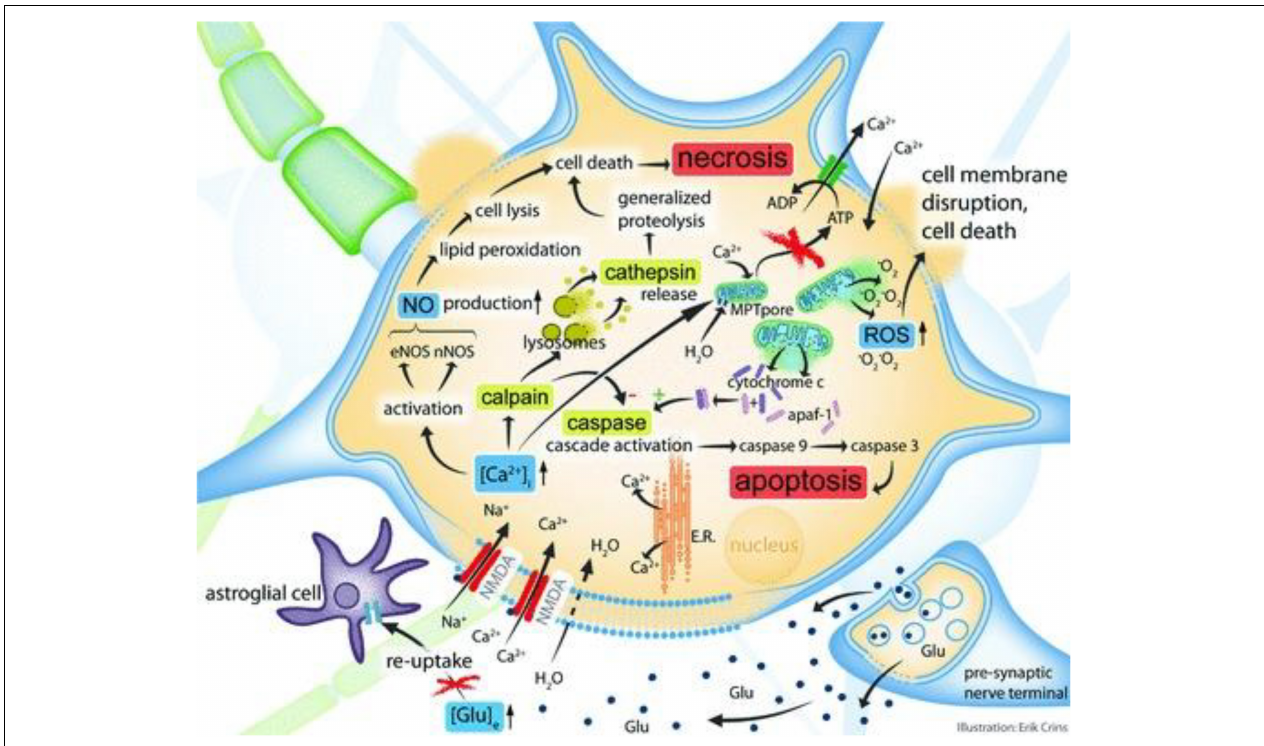
FIGURE 1 | Simplified cellular and molecular pathophysiological pathways after localized TBI. The figure is used to accompany the record provided in the actual section. In summary, elevations in extracellular glutamate cause a supraphysiological Ca2 + influx, which then activates some intracellular cascades acting in tandem (four are shown). Upregulation of the calcium-dependent enzymes eNOS and nNOS results in increased nitric oxide generation, which finally results in necrosis of cells and lipid peroxidation. The activity of calpain (a cystein protease) is also increased as a consequence of increased intracellular calcium, eventually culminating in cellular necrosis pathways. This process is facilitated by cathepsin release and lysosomal membrane disruption. Developments in intracellular calcium that cause mitochondrial calcium overload enhance the permeability of the mitochondrial membrane. As a consequence, reactive oxygen species (ROS) and the cytochrome-c protein are discharged into the cytoplasm. Cytochrome-c interacts with the apoptosis activating protein-1 (apaf-1), initiating the caspase pathway that induces apoptosis. Glu, glutamate; [Glu]e, extracellular glutamate concentration; NMDA, N -methyl- D -aspartate aspartic acid; E.R., endoplasmatic reticulum; [Ca2 + ]i, intracellular Ca2 + concentration; nNOS, neuronal NOS; eNOS, endothelial NOS; MPT, membrane permeability transition; ATP, adenosine triphosphate; O2 is an abbreviation for oxygen radical. Reproduced with permission from Andriessen et al. (2010).